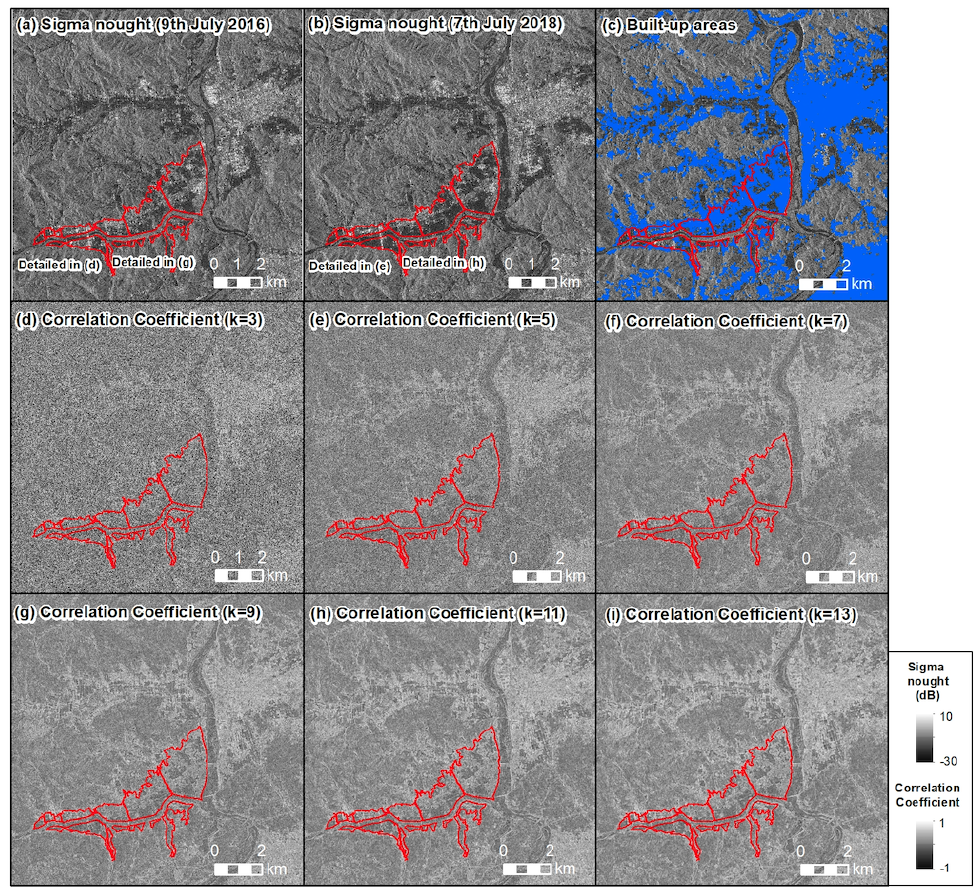
Figure 7. Examples of correlation coefficient images: ( a ) sigma nought image on 9 July 2016; ( b ) sigma nought image on 7 July 2018; ( c ) distribution of built-up areas, indicated by the blue color; ( d – i ) corre- lation coefficient image with ( d ) a kernel size of 3, ( e ) kernel size of 5, ( f ) kernel size of 7, ( g ) kernel size of 9, ( h ) kernel size of 11, and ( i ) kernel size of